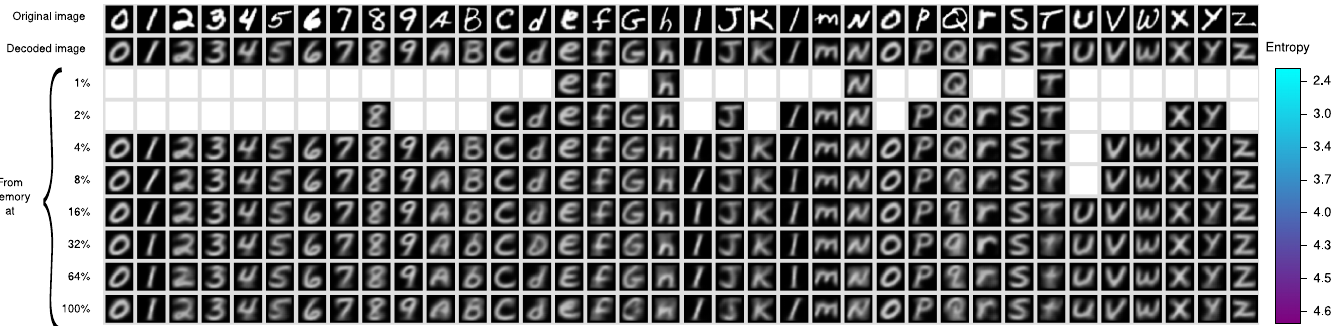
Fig 9. High quality cues. EMNIST-36 Symbols recovered with high quality cues as a function of the entropy.